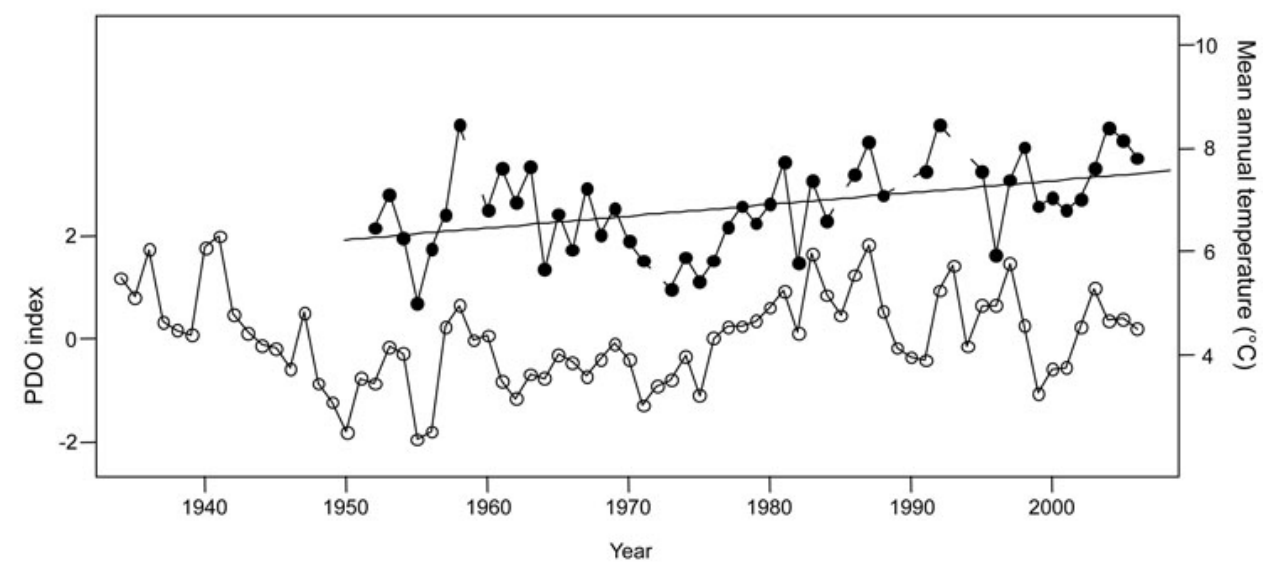
Fig. 3 . Mean annual air temperature (solid circles) at Kemano (53º33.8’ N, 127º56.9’ W, elevation 87 m above sea level, data from Environment Canada), and mean annual Pacific Decadal Oscillation (PDO) index values (Source: University of Washington Joint Institute for the Atmosphere and Oceans; open circles) (rtemp-PDO = 0.48, P < 0.001, for 1st-difference residuals). Originally published in Hill et al. 2009 by NRC Research